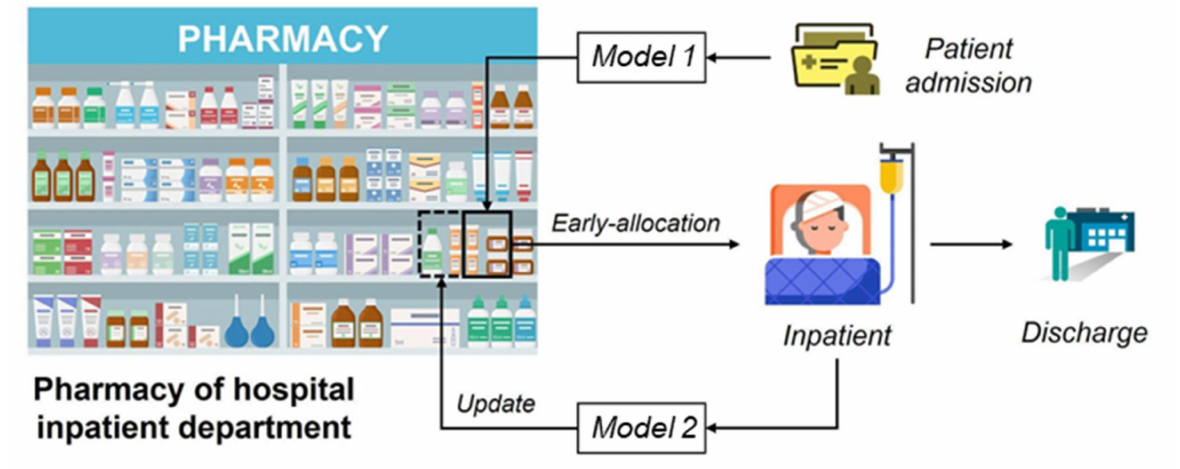
Figure 1. Patient-centric drug and medicine demand forecasting